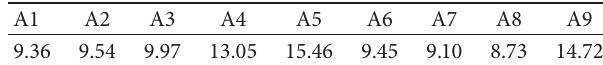
Figure 7: Water permeability coefficient versus gas permeability coefficient of concrete. Table 6: Porosity of test concrete